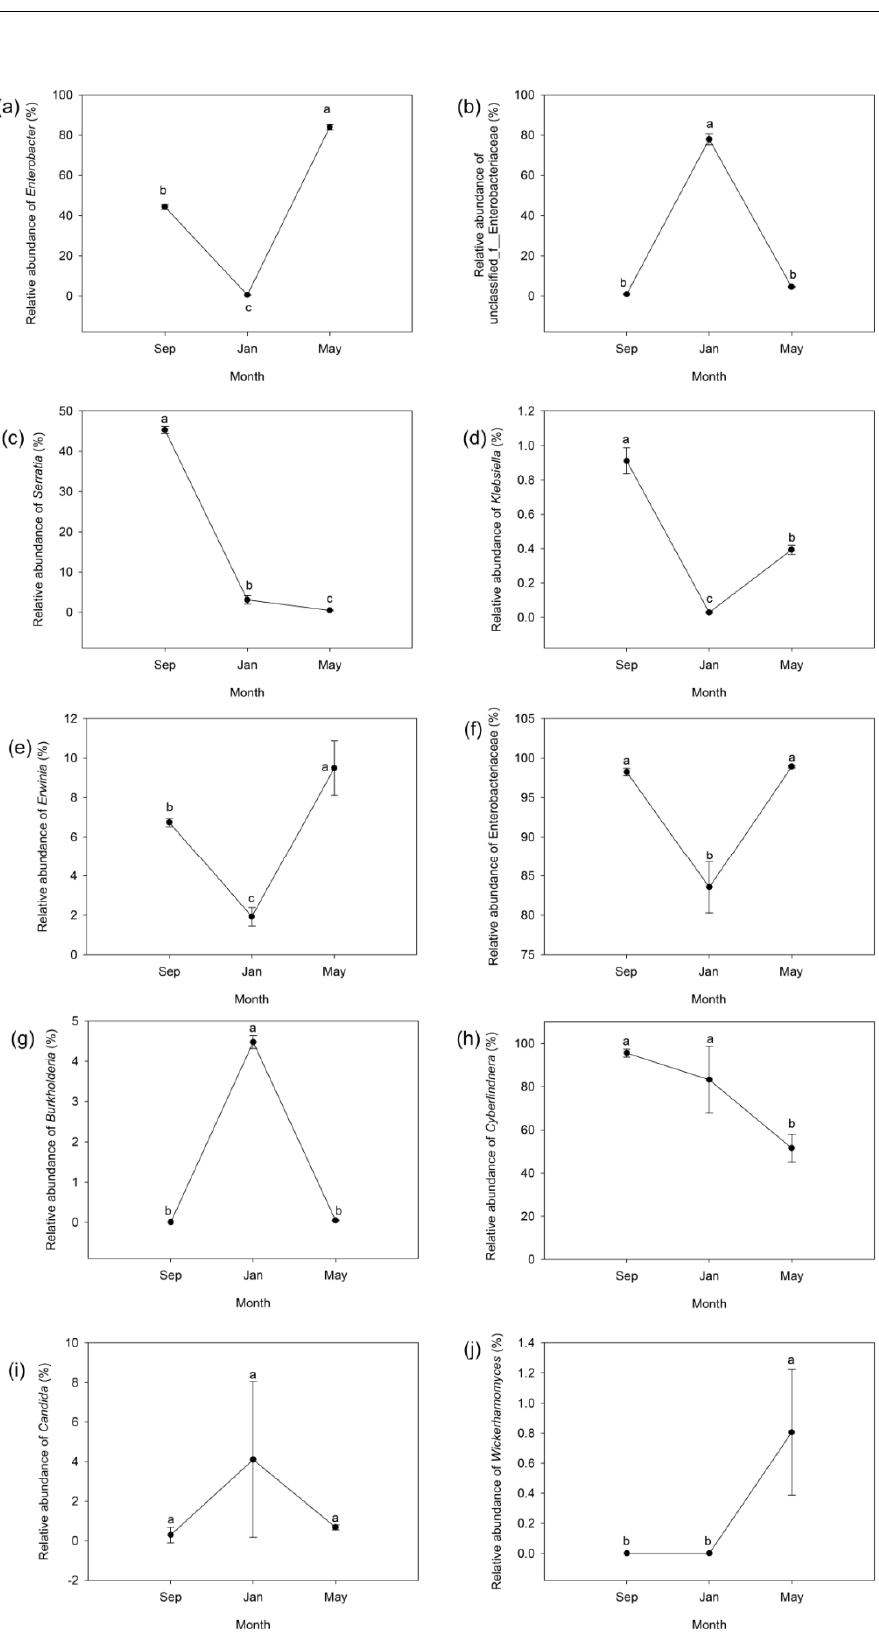
Figure 4. The relative abundances of the dominant microbial genera and families that showed the most variation across seasons. ( a ) Enterobacter , ( b ) unclassified_f__Enterobacteriaceae, ( c ) Serratia , ( d ) Klebsiella , ( e ) Erwinia , ( f ) Enterobacteriaceae, ( g ) Burkholderia , ( h ) Cyberlindnera , ( i ) Candida , ( j ) Wickerhamomyces . Results are shown as the mean ± standard deviation.